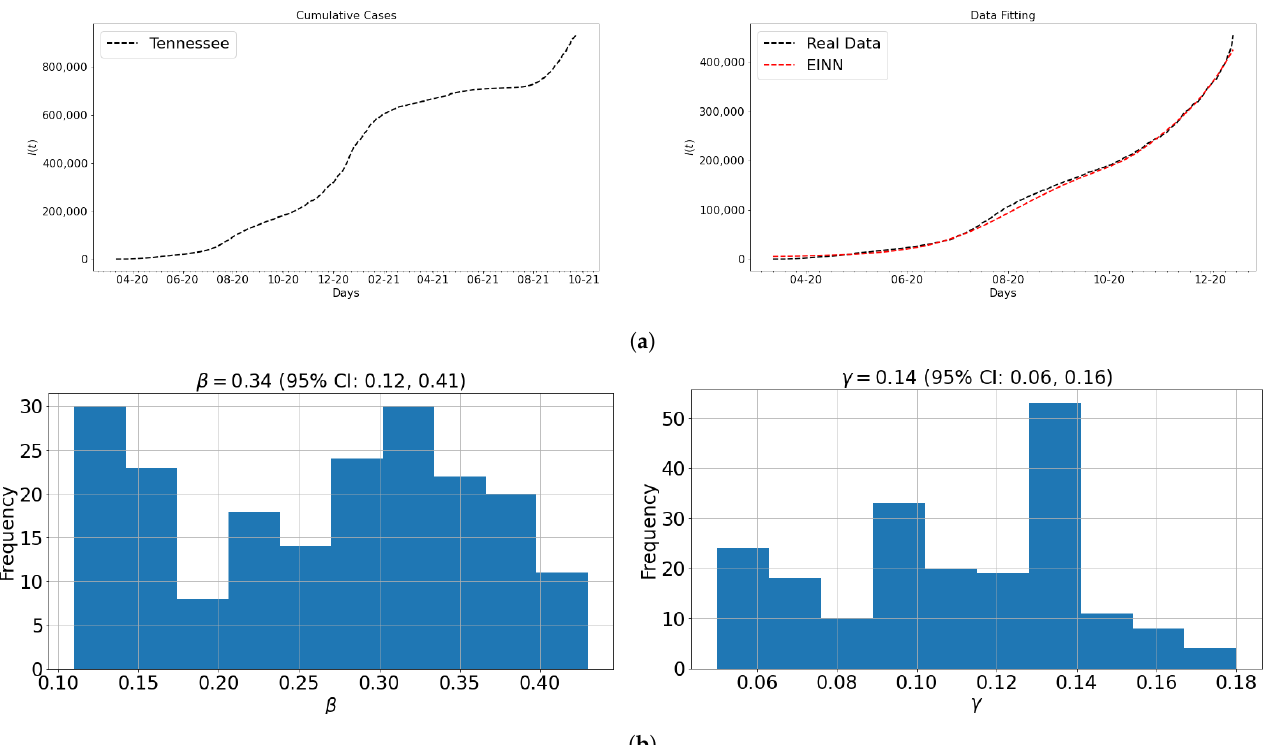
Figure 7. Data Preprocessing and Data Fitting; ( a ) the data (top panel) and data fitting (bottom panel) are graphed; ( b ) the 95% confidence interval is constructed for β and γ for